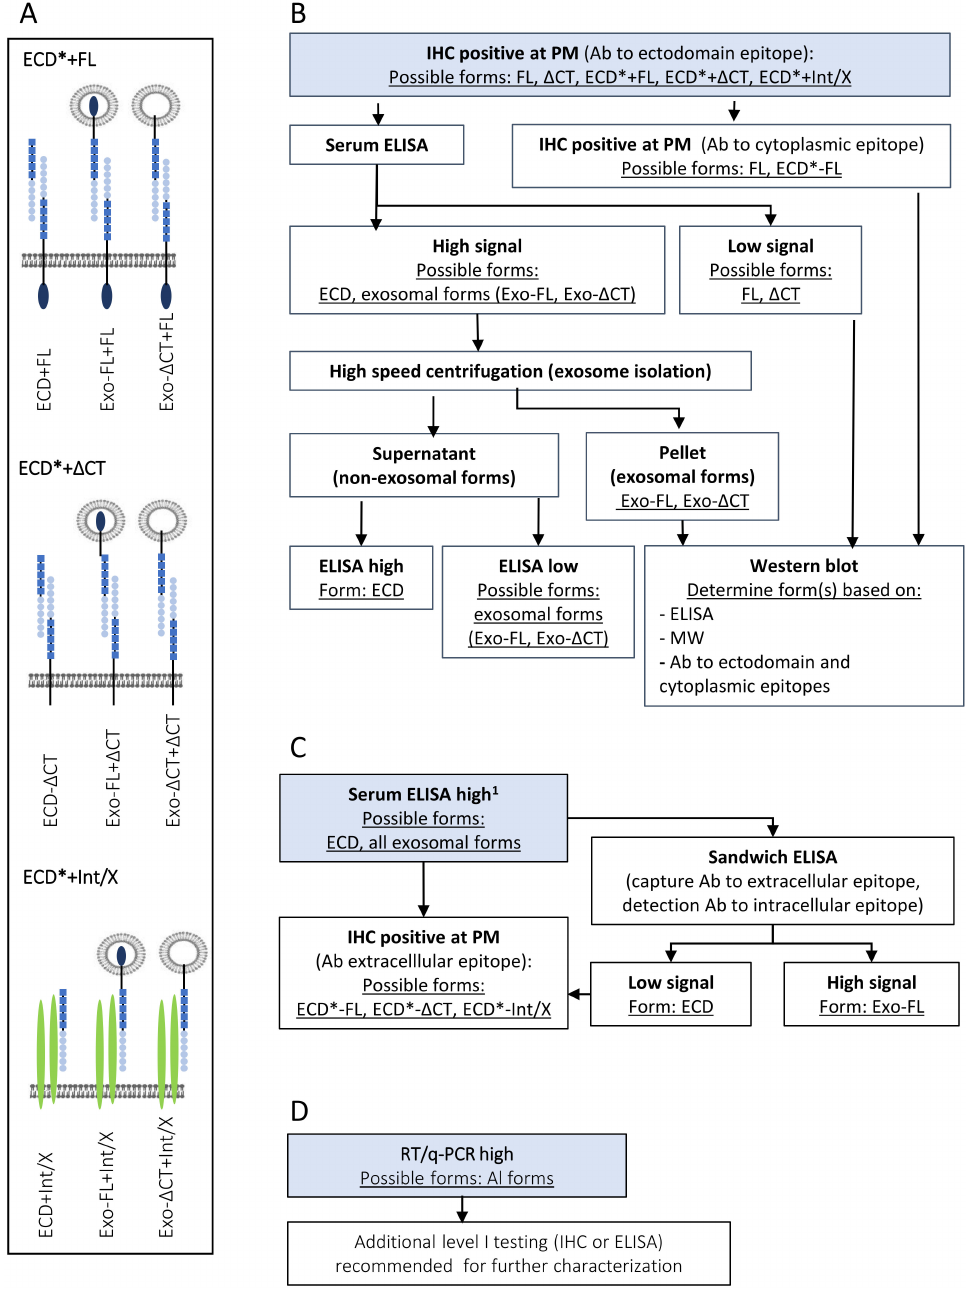
Figure 5. Suggested algorithm for the assessment of the form and location of L1CAM based on common clinical analyses of L1CAM expression. ( A ) Analysis of L1CAM is most commonly assessed by IHC using ECD-domain-reacting antibodies. In addition to recognizing L1CAM-FL or L1CAM- ∆ CT, positive staining at the plasma membrane can represent homotypic interactions of L1CAM-FL or L1CAM- ∆ CT with soluble ECD, or with exosomal forms expressing the ECD (collectively indicated ECD * + FL or ECD * + ∆ CT). Positive staining at the plasma membrane may also be due to heterotypic interactions of ECD-containing soluble or exosomal L1CAM forms with other proteins, such as integrins (Int) or other undefined proteins (X). These heterotypic interactions are indicated with ECD * + Int / X. ( B ) Suggested diagnostic algorithm based on initial positive IHC staining with an ECD-domain-reacting antibody. Suggested follow-up analysis should includes ELISA analysis of serum to determine the level of soluble forms. The presence of FL can be assessed by IHC using a CT-domain-specific antibody, the staining of which should overlap with ECD-specific antibody staining in case of expression of FL. More